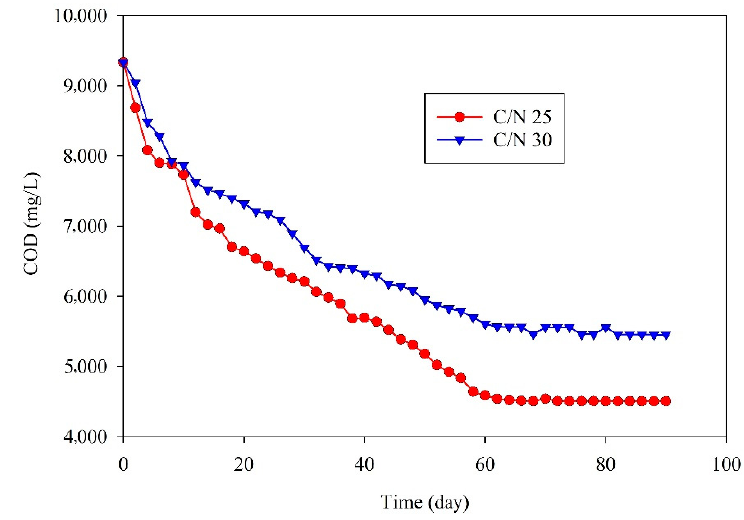
Figure 7. Effect of different C/N ratios on the chemical oxygen demand (COD) reduction of 20% total solids (TS) biogas non-delignification.